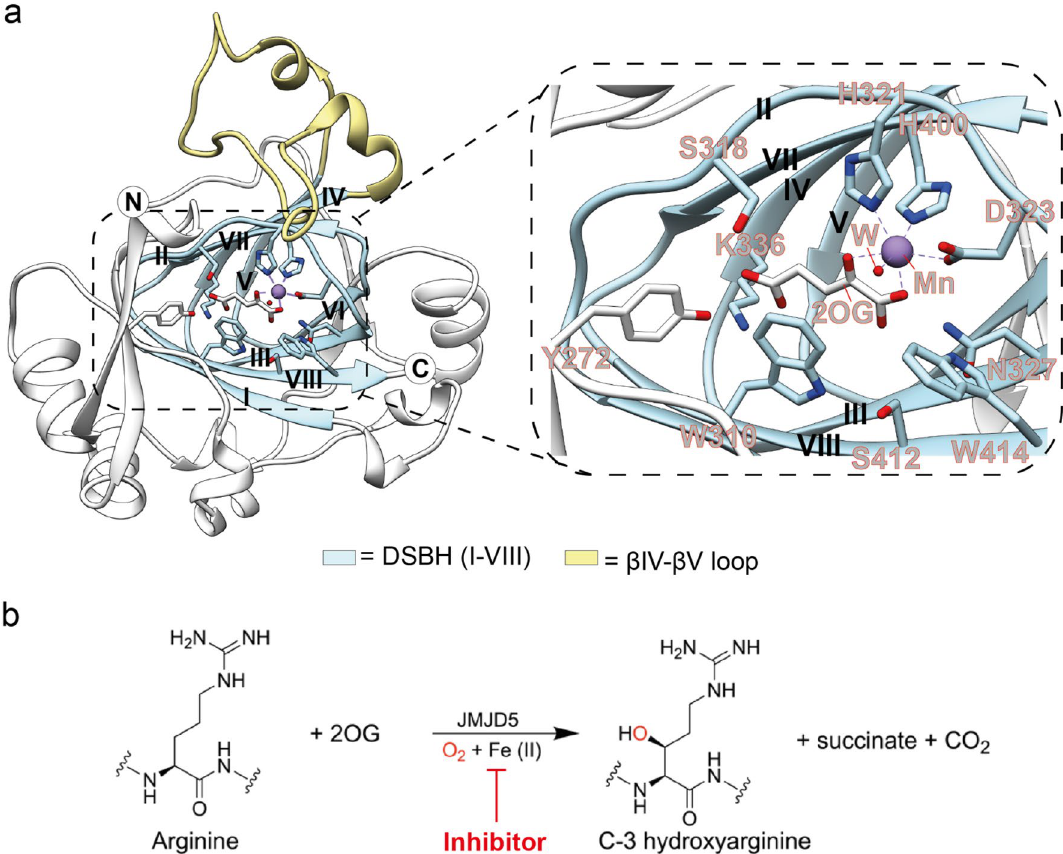
Figure 1. JMJD5 catalyses C-3 arginine-residue hydroxylation. ( a ) View derived from a crystal structure of JMJD5 ∆1–181 in complex with Mn (substituting for catalytically active Fe) and 2OG (PDB: 6F4N) showing